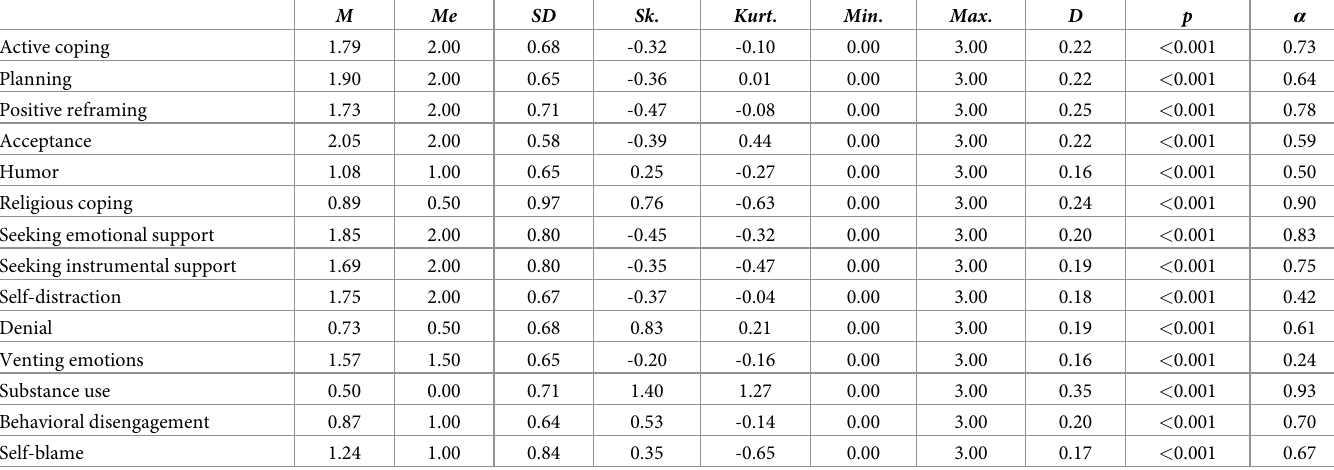
Table 3. Basic descriptive statistics with the Kolmogorov-Smirnov test of normality and reliability (Cronbach’s α ). M Me SD Sk . Kurt .